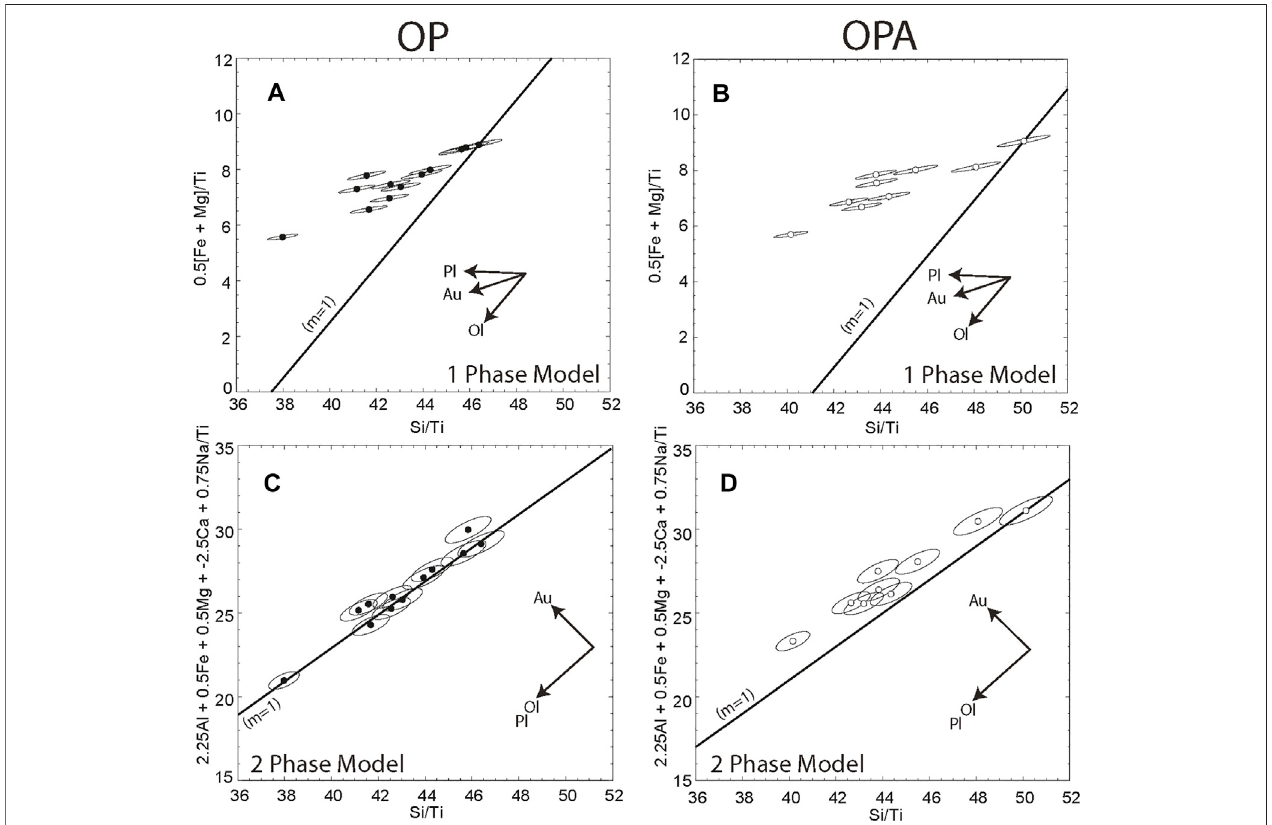
FIGURE6| ChemicalvariationsforCrackedMountainsamplesillustratedwithPearceElementRatio(PERs)assemblagetestdiagrams(StanleyandRussell,1989). Symbolsinclude OPsuite(black circles) and OPA suite (white circles). Ellipses denote 2s analytical uncertainty for each data point. In each plot, a model line witha slope of1isprojectedthroughthedataset ’ smostprimitivepoint. Mineralresponse vectorsareshown forolivine(Ol),plagioclase(Pl),andAugite (Au) (A) Single-phase(olivine) assemblage test for OP and (B) OPA samples, respectively. Both suites fall off the model line and therefore chemical variations cannot be explained by the crystal sorting of olivine alone (C) Two-phase (olivine-plagioclase) assemblage test for CM OP samples. Nearly all samples fall within 2s uncertainty of the model line, indicating the chemical variation within OP samples can be attributed to the crystal sorting of olivine and plagioclase. (D) Same assemblage test as shown in plot C, now with CM OPA samples. Here the OPA samples fall above the model line, indicating the chemical variation cannot be explained by crystal sorting of olivine and plagioclase